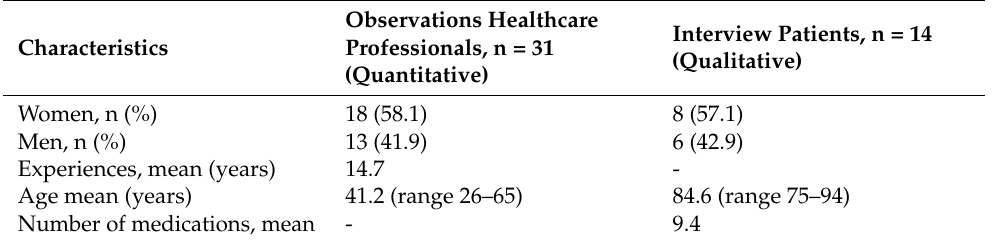
Table 3. Participant